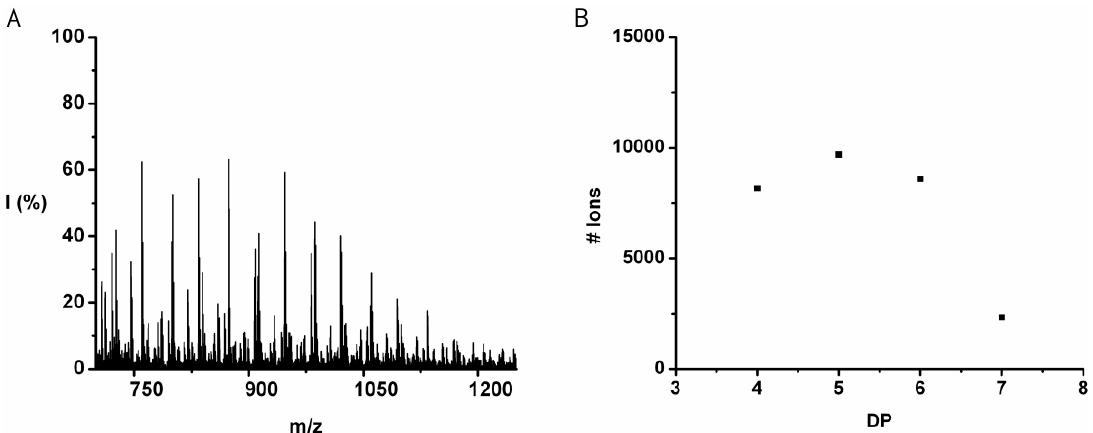
Figure 26. ( A ) MALDI-ToF mass spectrum of oligo(Phe-co-Leu-co-Trp) and ( B ) chain length distribution of oligo(Phe-co-Leu-co-Trp).